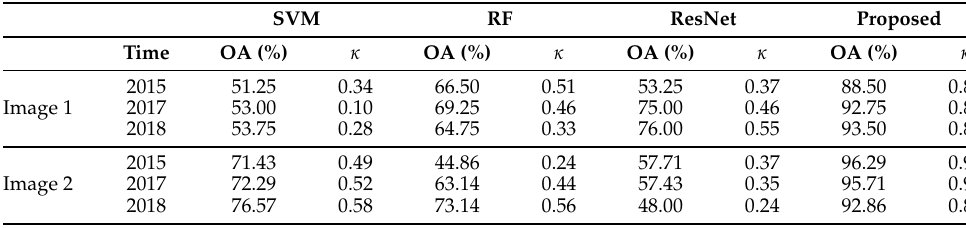
Table 6. Comparison of the accuracy of the four wetland classification